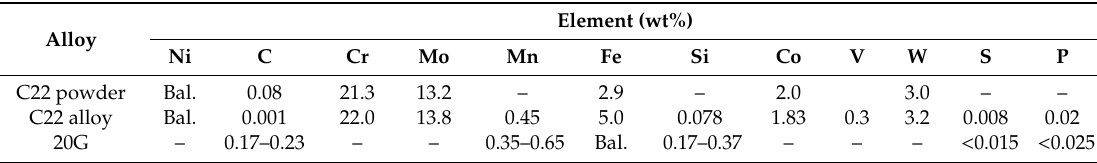
Table 1. Chemical compositions of C22 powder, C22 alloy and 20G steel.